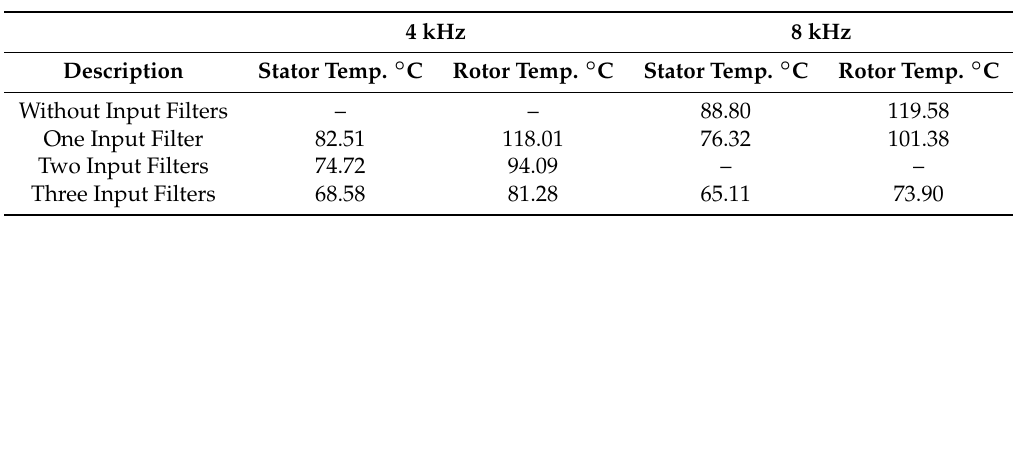
Figure 14. Temperature profiles during thermal equilibrium with one resistor–inductor (RL) filter at 8 kHz with three, one and zero input filters: ( a ) thermocouples on stator winding; ( b ) thermocouples on permanent-magnets . Table 3. Stator windings and permanent-magnet temperatures of the reference SPM motor at different PWM switching frequencies and input filtering